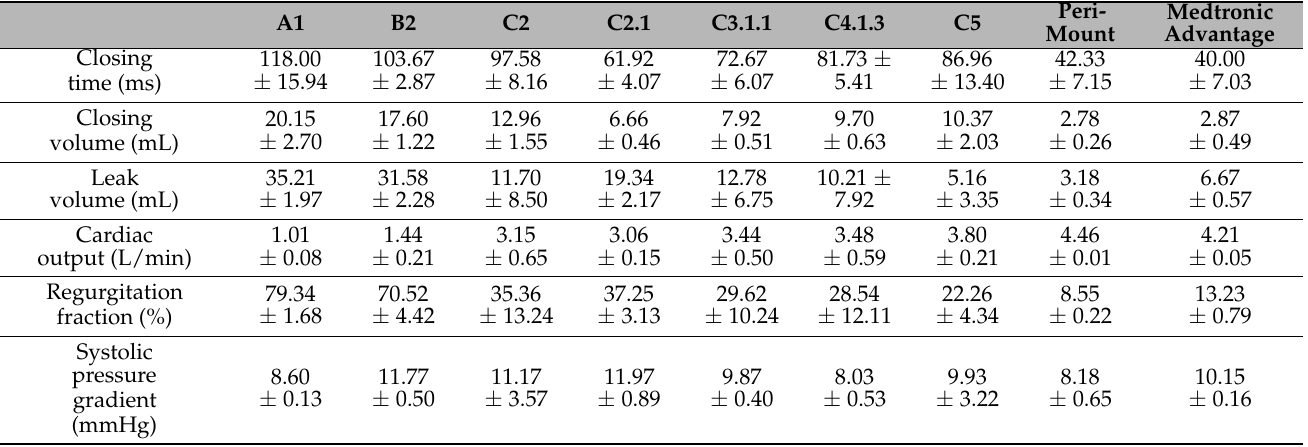
Table 1. Performance characteristics of the presented prototypes. For comparison, values are given for a biological (Edwards Perimount 23 mm) and mechanical prosthesis (Medtronic Advantage 23 mm) within our measurement